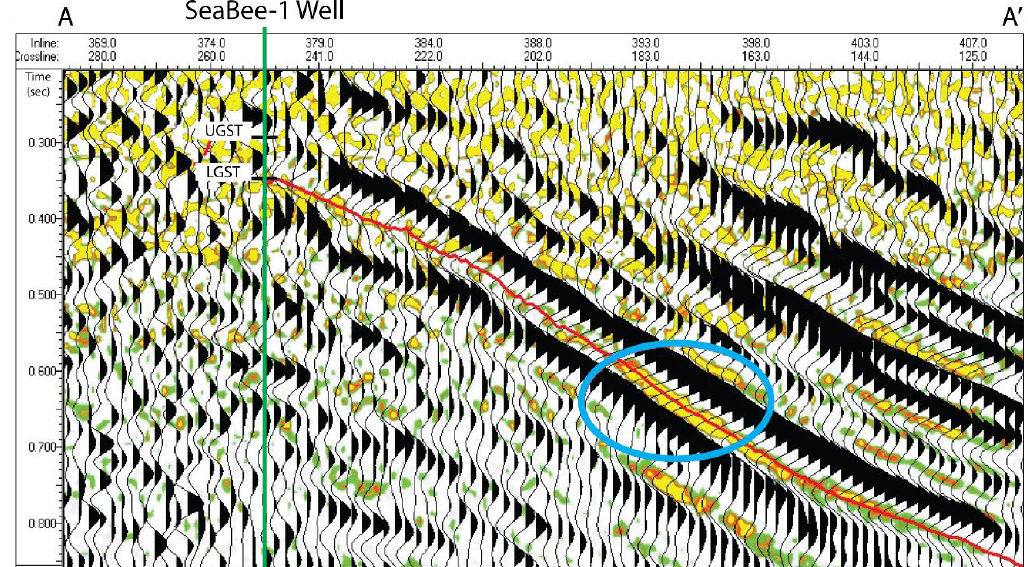
Figure 8. Seismic cross-section, representing the amplitude variation with offset (AVO) effect of the top sandstone reservoir facies along the horizon (marked in red) in the Lower Grandstand Formation.